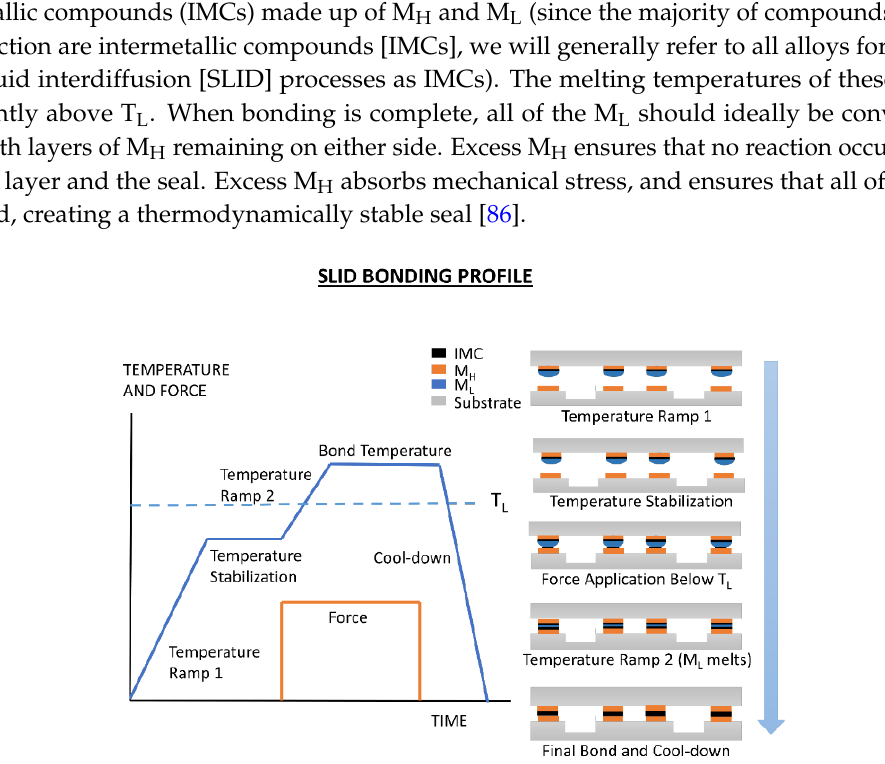
Figure 7. Typical solid-liquid interdiffusion (SLID) bonding process flow. Wafers are heated to a temperature below the bonding temperature, mechanical force is applied, and the wafers are heated above the low melting temperature (T L ). Naming convention adopted from Hoivik et al.